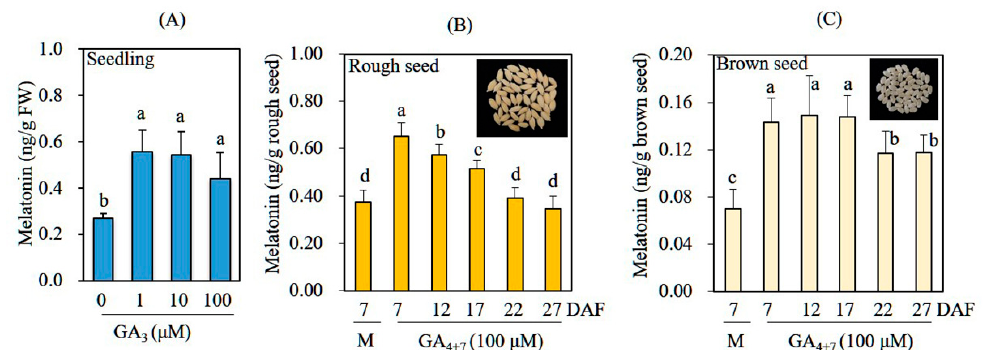
Figure 3. Melatonin levels in ( A ) rice seedlings, ( B ) rough seeds, and ( C ) brown seeds after treatment with GA in the absence of cadmium treatment. Seven-day-old rice seedlings were treated with various concentrations of GA 3 for 24 h; leaves or seeds were subjected to HPLC quantification of melatonin. In addition, immature rice seeds were treated at various time intervals with 100 μ M of commercially available GA 4+7 (Daeyu Co., Ltd.) three times every other day in the field. After 60 days after flowering (DAF), rice seeds were harvested for melatonin quantification. Different letters denote significant differences ( p < 0.05; ANOVA, followed by Tukey’s HSD post hoc tests). M, water containing 0.1% ethanol; GA 3 , gibberellic acid 3.